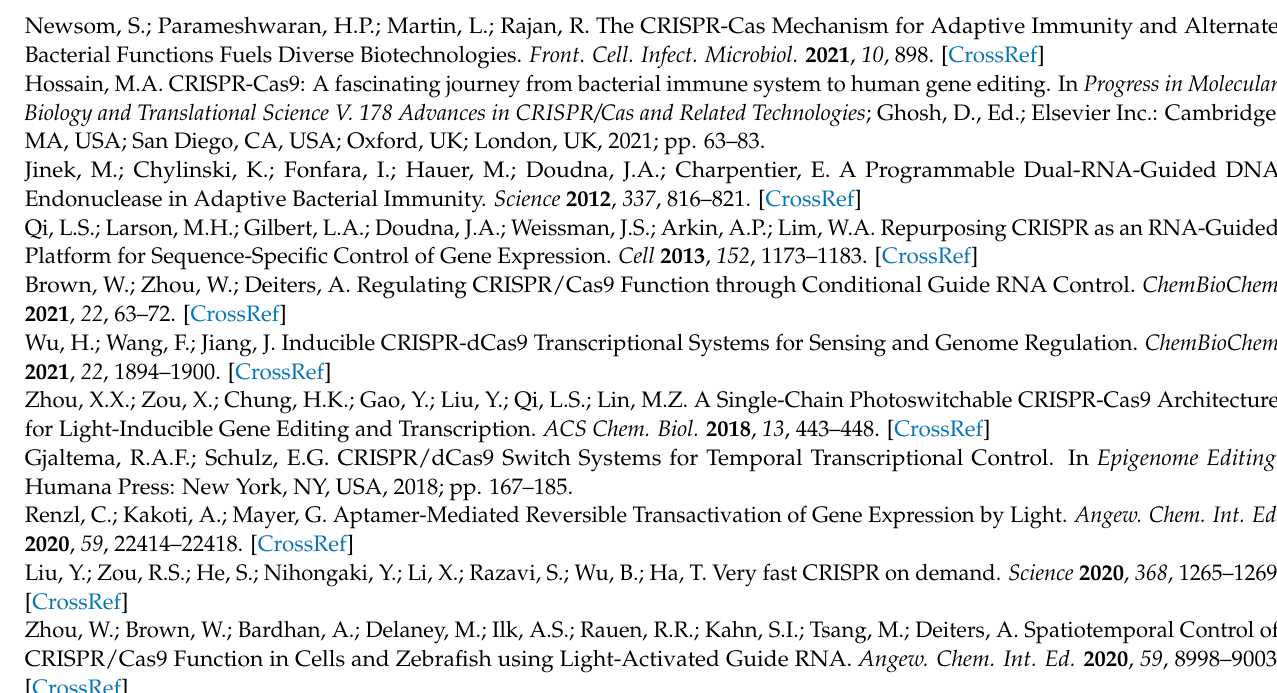
Figure S2: The release of fluorescent crRNA_Flu immobilized on CNP surface through the auxiliary pyrene-modified PC-DNA upon UV irradiation, Figure S3: The CEINPs characterization, Table S1: PC-DNA and their 3 (cid:48) -pyrene containing conjugates, crRNA, and tracrRNA, Table S2: Molecular mass for oligonucleotides and their 3 (cid:48) -pyrene conjugates, Table S3: Dissociation constants and melting temperatures of the duplexes of PC-DNA and their analogs with